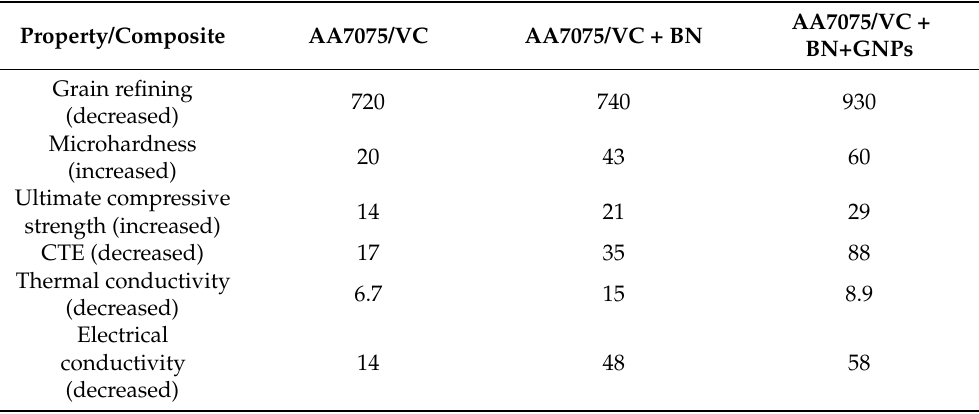
Table 3. The overall improvement in the grain size, mechanical, physical, and service properties. All values in % and with respect to the AA7075 base metal.